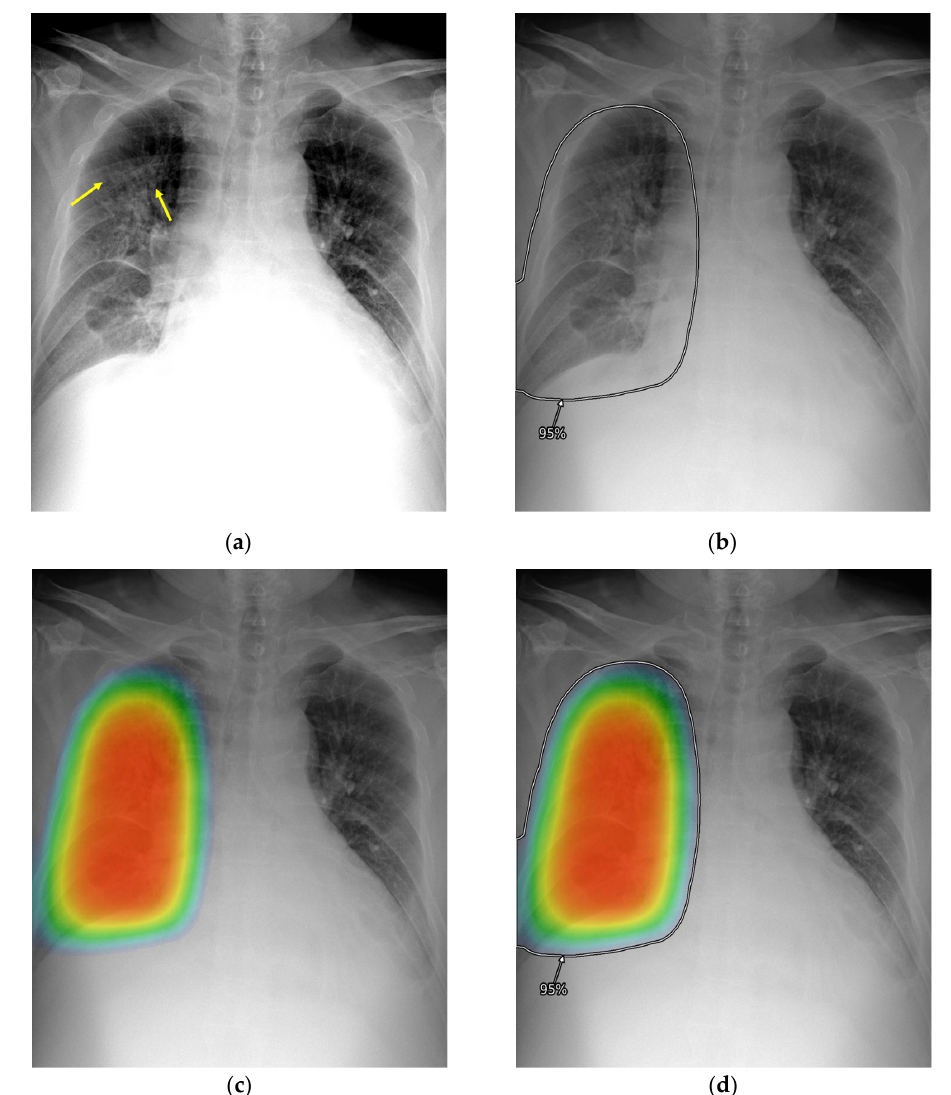
Figure 1. Representative examples showing that the advantages of the heat map method can complement the disadvantage of the closed-line method. ( a ) Chest radiography of a 75-year-old man who visited an emergency department with chest pain showed right pneumothorax (arrows). The artificial-intelligence-based computer-aided detection (AI-CAD) detected pneumothorax with a probability score of 95%. With visualization of AI-CAD result by closed-line method ( b ), one of five radiologists missed the pneumothorax. Meanwhile, with heat map method ( c ) and combined method ( d ), all five trainee radiologists identified the abnormality.